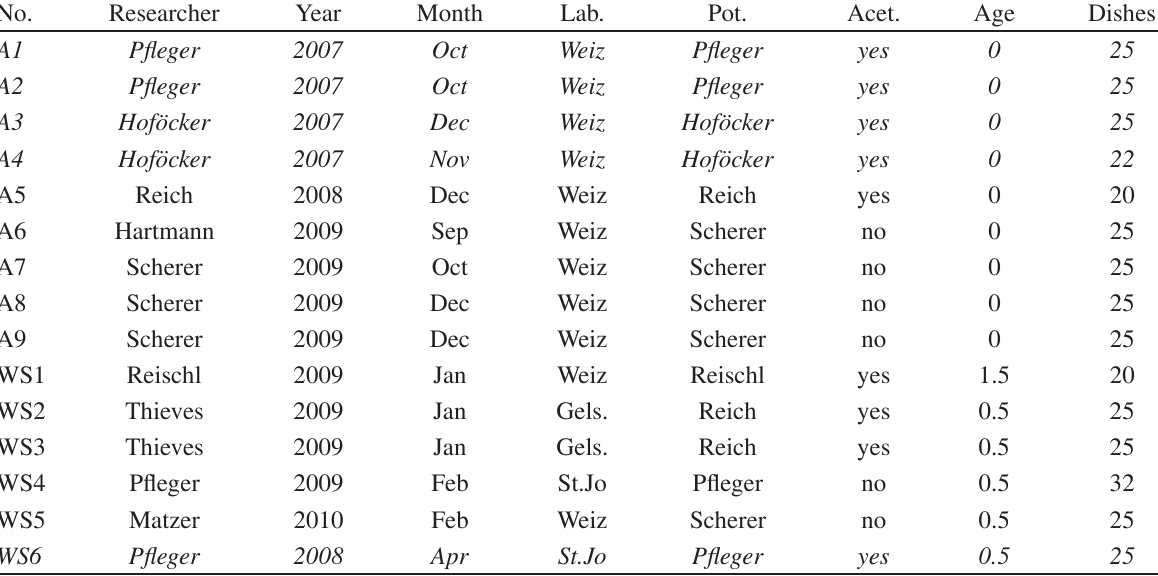
TABLE 1: Overview of 7-day experiments on wheat stalk growth under the influence of potentized gibberellic acid (G30x) versus analogously potentized solvent (W30x) carried out at the Interuniversity College in the time from 2007 to 2010. Work is shown subdivided into batches of ca. 500 grains G30x and